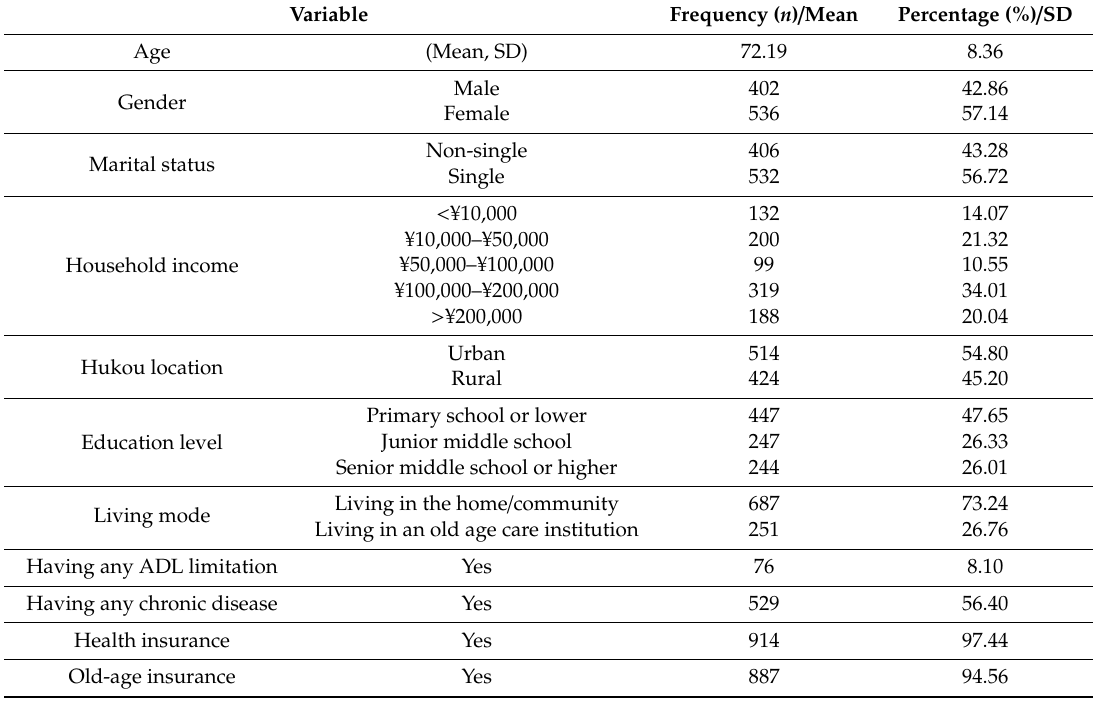
Table 2. Descriptive statistics of the sociodemographic variables ( N = 938).